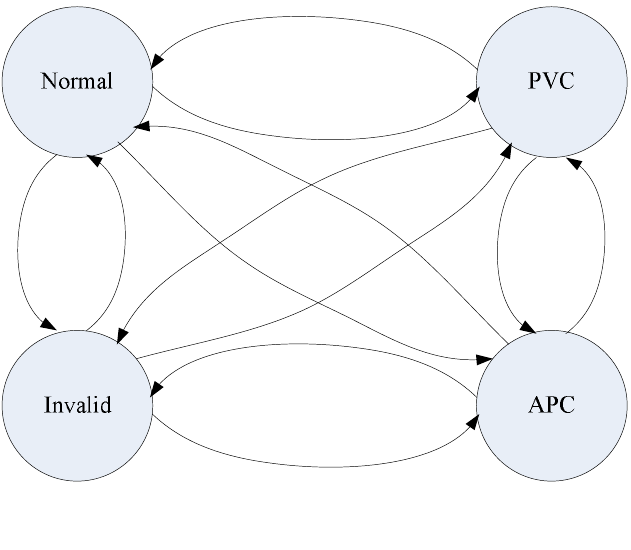
Figure 16. The structure of Layer 2 HMM for cardiac arrhythmia detection. “Normal” means a normal beat, and “Invalid” means an invalid